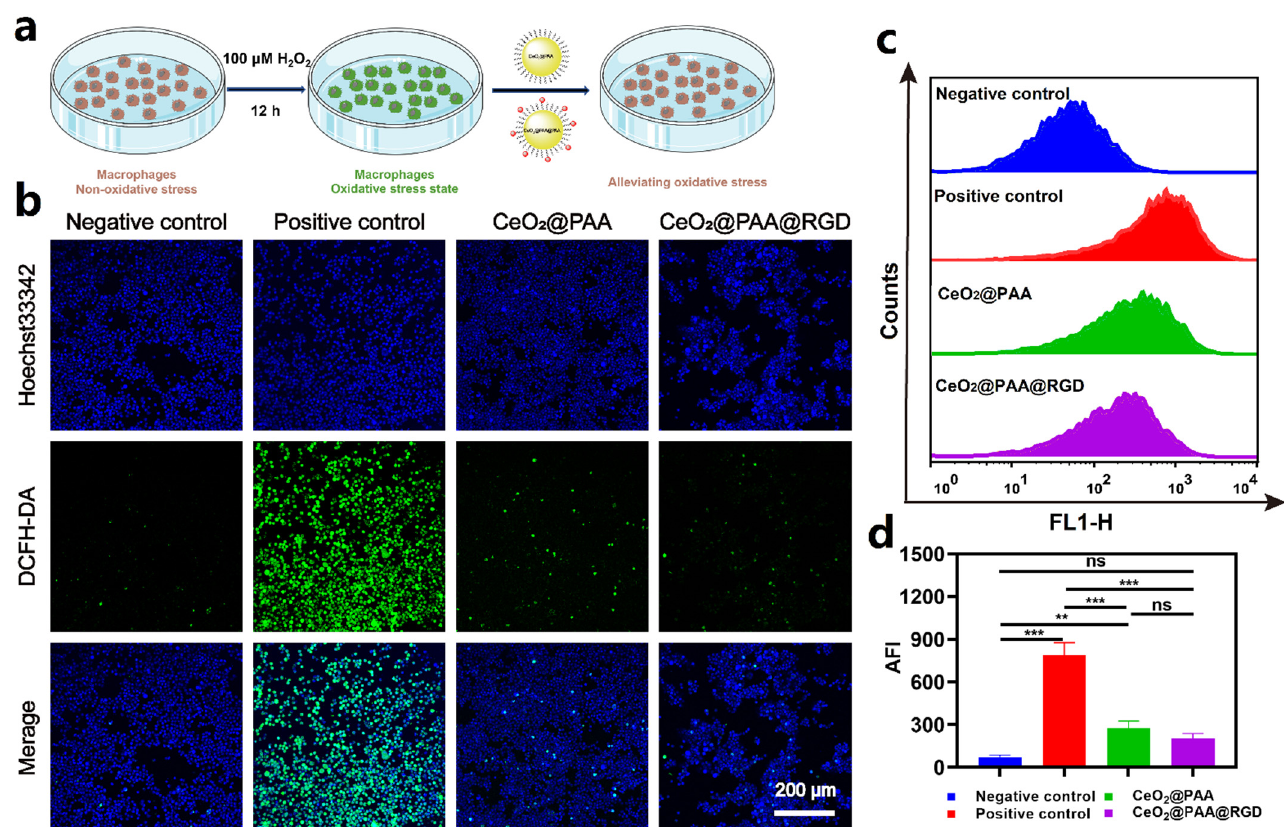
Figure 3. CeO 2 @PAA@RGD inhibited ROS production in Raw264.7 cells inducted by 100 µM H 2 O 2 scavenging capability of CeO 2 @PAA@RGD in Raw264.7 cells; ( b ) CLSM observation showing relative intracellular ROS levels after CeO 2 @PAA@RGD treated for 24 h. ROS were stained with DCFH-DA fluorescent probe (green) and nuclei were stained with Hoechst 33342 (blue). Scale bar = 200 µm; ( c ) histogram of ROS levels in Raw264.7 cells treated with CeO 2 @PAA@RGD nanoparticles for 24